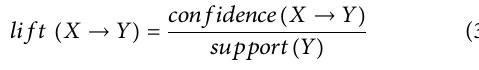
Frontiers in Environmental Science |